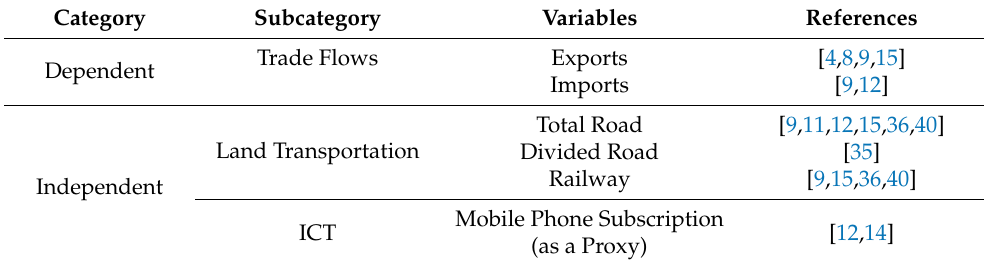
Table 1. Variables and